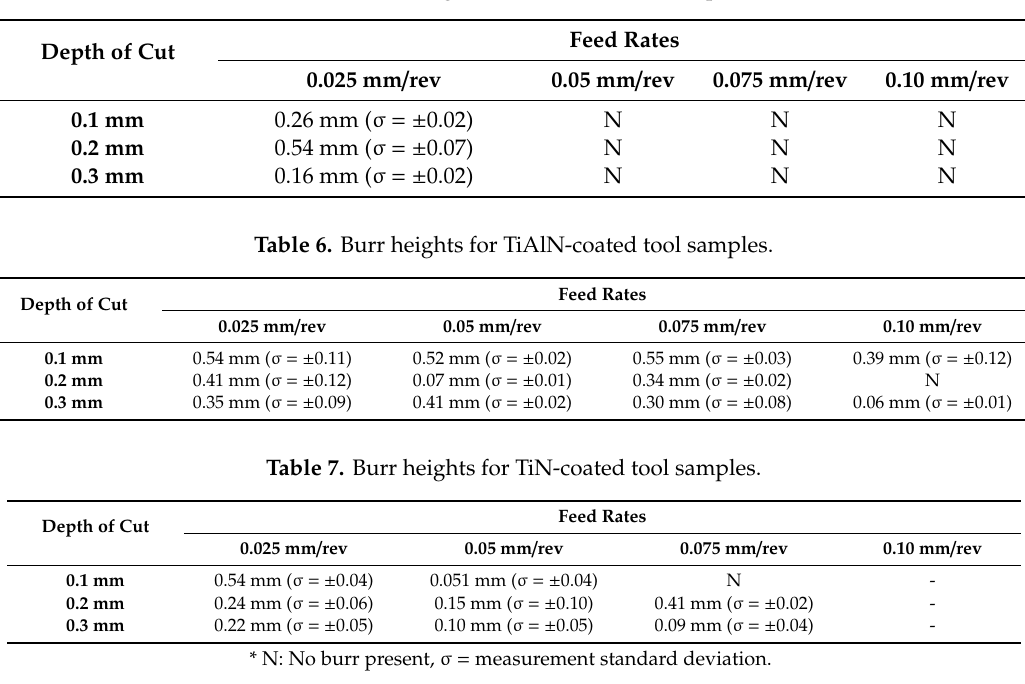
Table 7. Burr heights for TiN-coated tool samples.